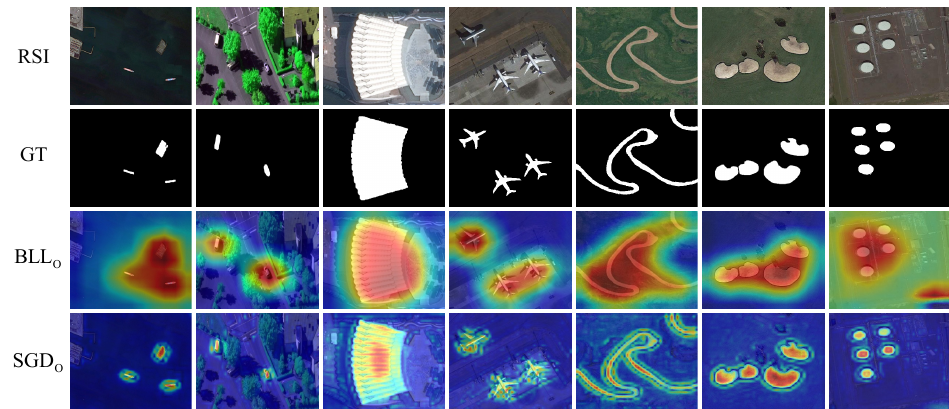
Figure 4. Visualization comparison between the output features of the last layer of the backbone network ( BLL o ) and the output of the SGD module ( SGD o ) .